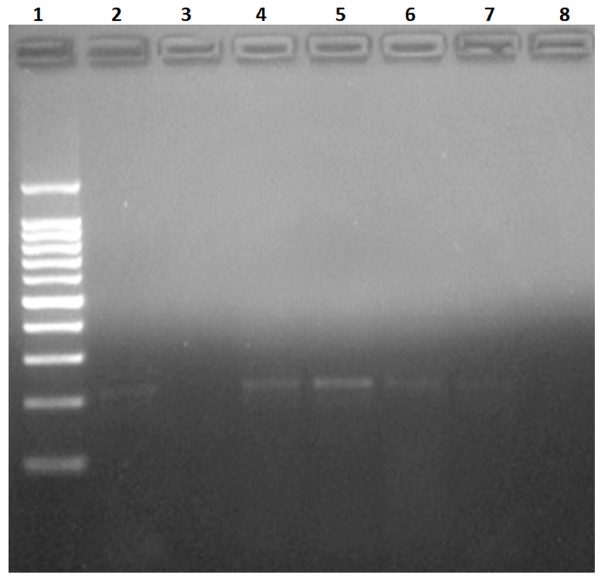
Figure 5. Agarose gel electrophoresis showing PCR positivity of four patients with presumptive cases of AA. Lane 1: Molecular weight markers (100-pb ladder). Lane 2: DNA from Angiostrongylus costaricensis (positive control). Lane 3: Negative control. Lanes 4–7: Presumptive cases with respective DNA concentrations: 6.9 m g/mL; 7.52 m g/mL; 2.3 m g/mL; 2.1 m g/mL. Lane 8: Mix (reaction control for detection of possible contaminants).